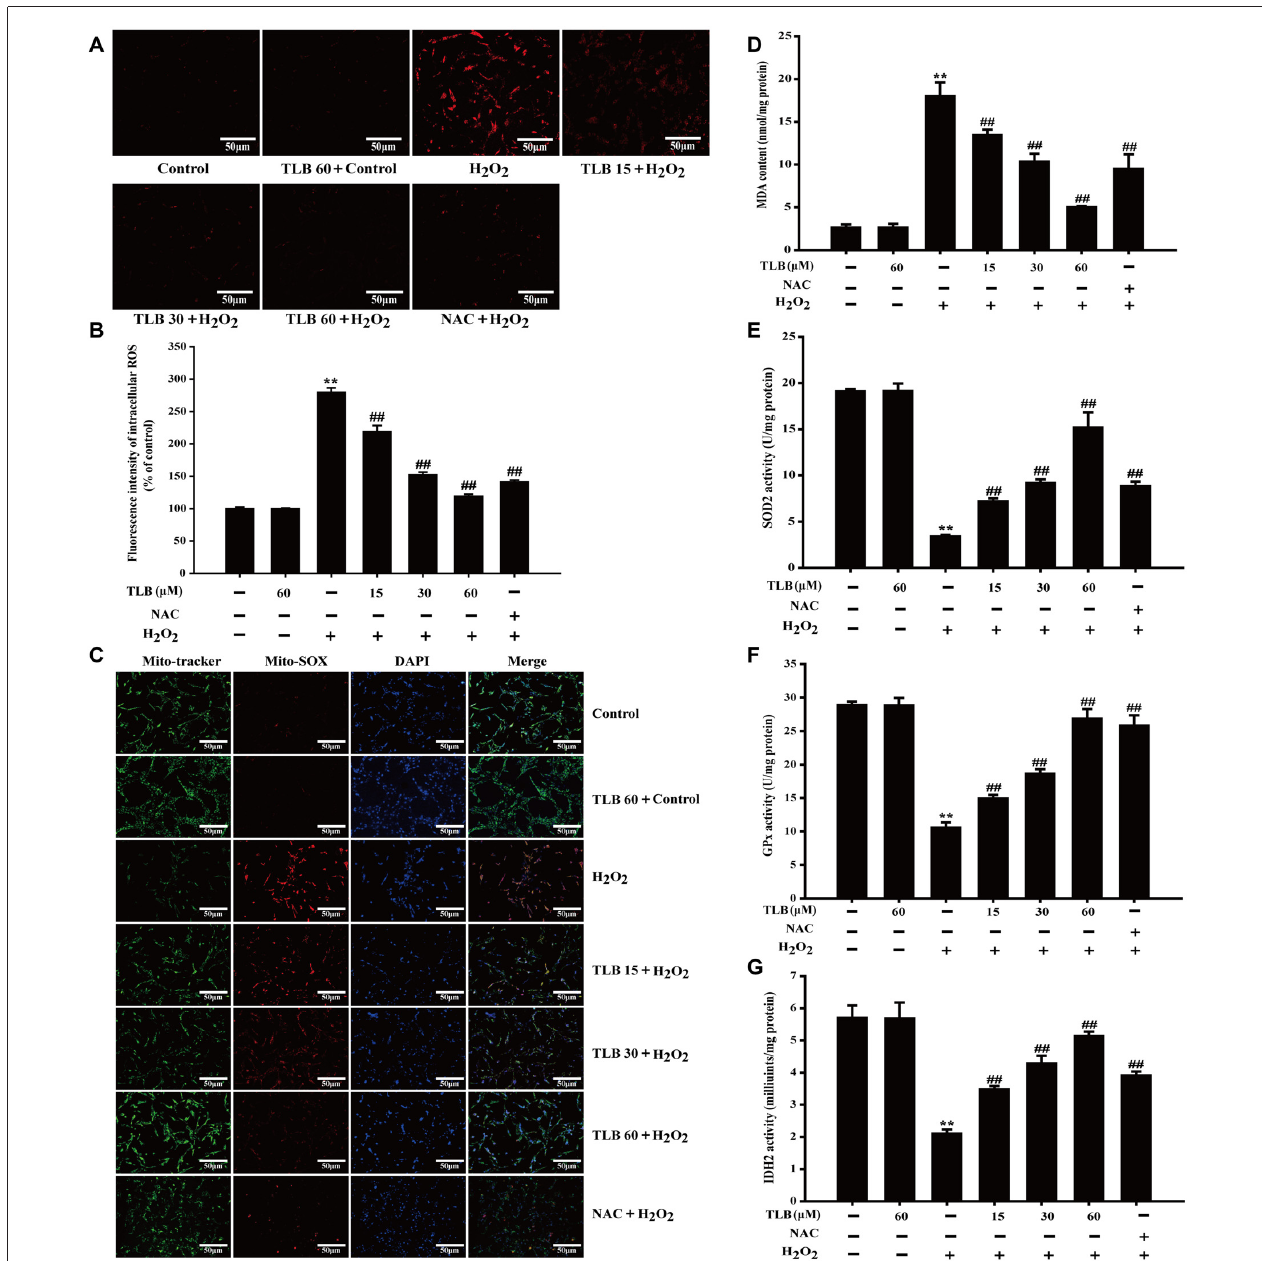
FIGURE 3 | TLB suppressed H 2 O 2 -induced accumulation of intracellular reactive oxygen species (ROS) and mitochondrial superoxide (O • − 2 ) and improved mitochondrial enzyme activities. After pre-treatment of PC12 with or without TLB for 1 h, cells were treated with 400 µ M H 2 O 2 for another 48 h. (A) Intracellular ROS production was determined using 2’,7’-dichlorodihydrofluorescein diacetate (DCFH-DA) staining. Magnification, 200 × ; scale bar = 50 µ m. (B) The mean fluorescence intensity of intracellular ROS was quantified using Image-Pro Plus software. (C) Mitochondrial O • − 2 production was determined using MitoSOX Red staining. MDA content and enzymatic activities of superoxide dismutase 2 (SOD2), glutathione peroxidase (GPx), isocitrate dehydrogenase 2 (IDH2) were determined using according kits. Magnification, 200 × ; scale bar = 50 µ m. (D) MDA content. (E) SOD2 activity. (F) GPx activity. (G) IDH2 activity. Data were presented as mean ± SD of three independent experiments. ∗∗ P < 0.01 vs. untreated control cells; ## P < 0.01 vs. H 2 O 2 -treated cells.